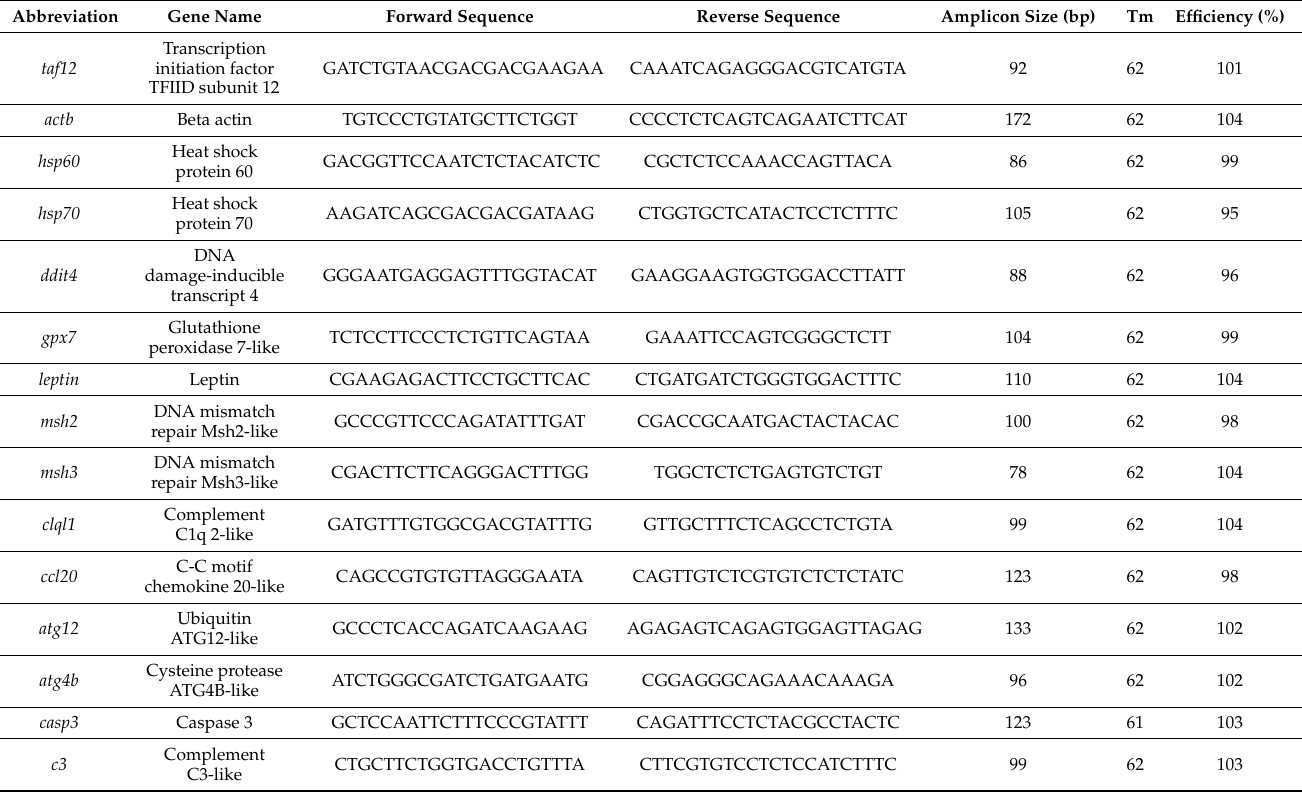
Table 1. Primer sequence, amplicon size, Tm and efficiency of validated genes by